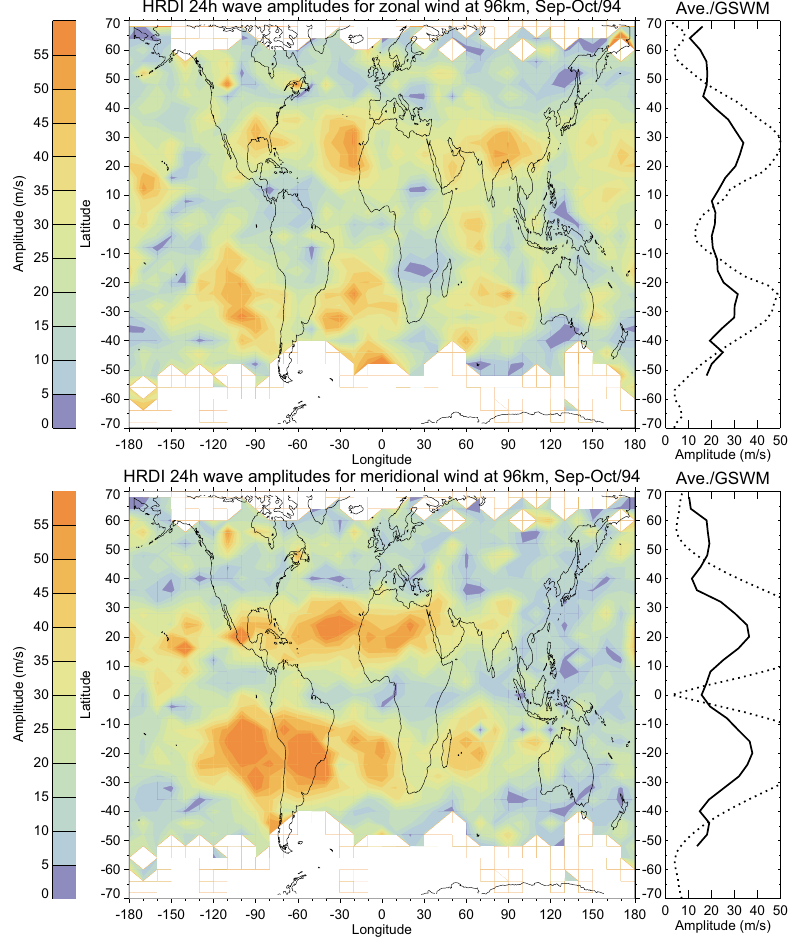
Fig. 5. Contoured plots of 24-h tidal amplitudes for September–Octo- ber 1994 from HRDI. The longitudinal averages are to the right (solid line), and also the GSWM-2000 values